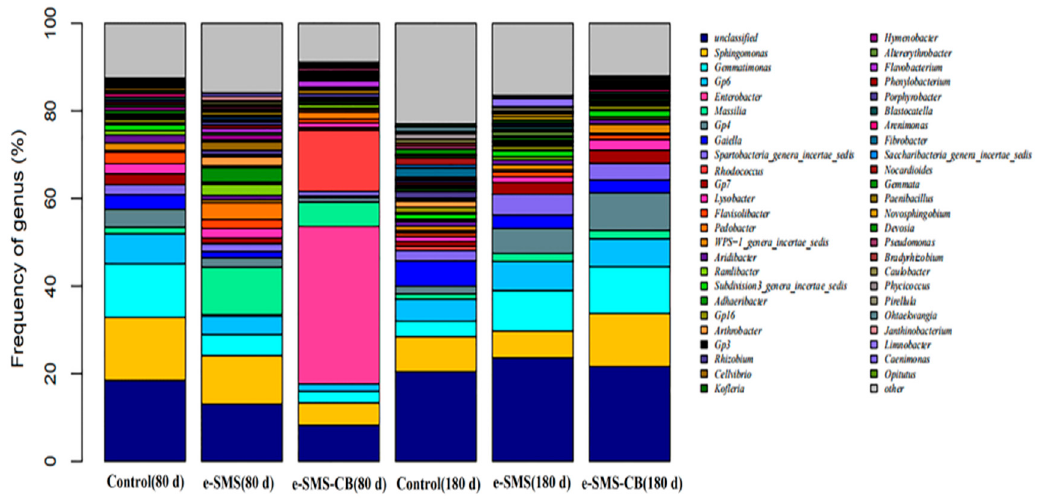
Figure 3. Principal component analysis (PCA) of all six samples based on microbial community composition. Control: real soil as control group; e-SMS: real soil + P. eryngiu -SMS; e-SMS-CB: real soil + P. eryngiu -SMS-CB.